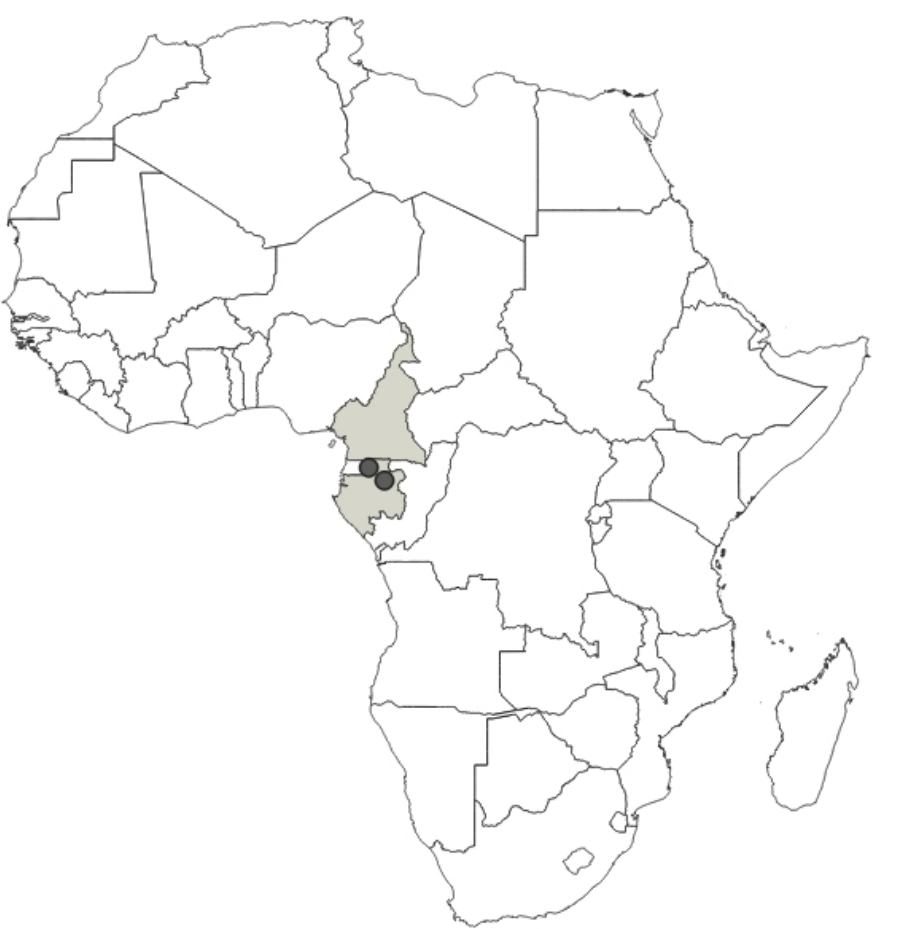
Figure 33. Known distribution of Phonoctonus bifasciatus Villiers, 1948.